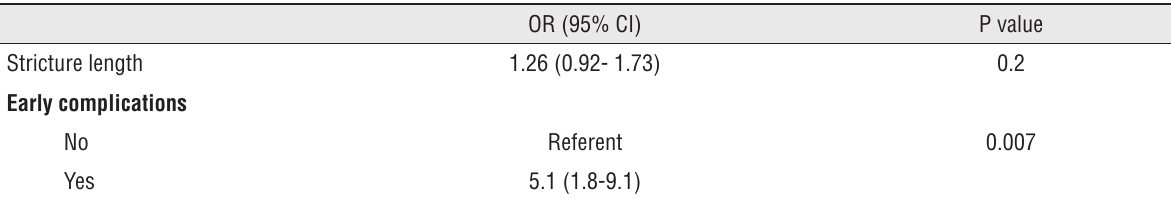
Table 4 - Multivariate analysis for predictors of